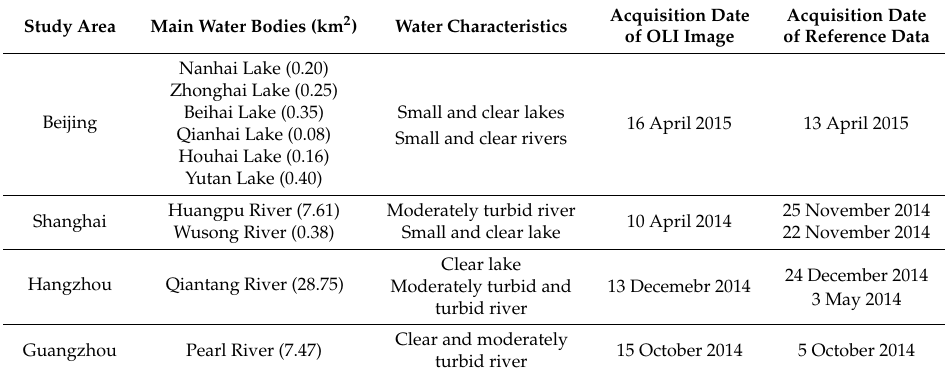
Figure 1. Study areas: Beijing, Shanghai, Hangzhou, and Guangzhou, China, illustrated in false-color composite (RGB: bands 6, 5, 2) Landsat OLI images overlaid by the main water bodies of these areas. Table 1. Details of the study